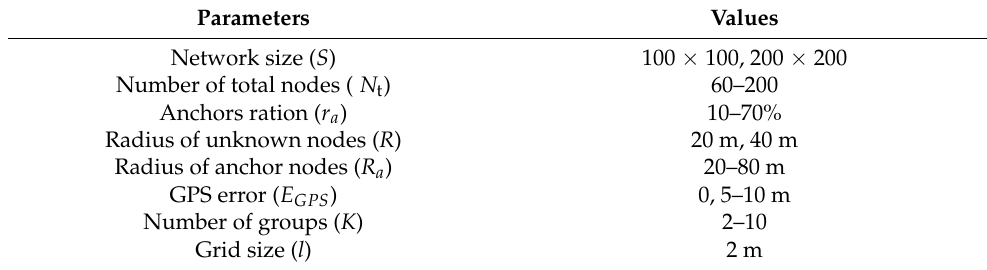
Table 2. Simulation parameters and